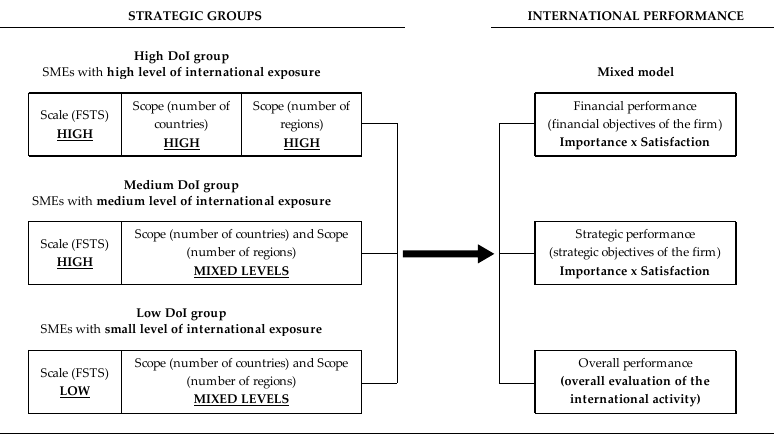
Figure 1. Conceptual model overview.